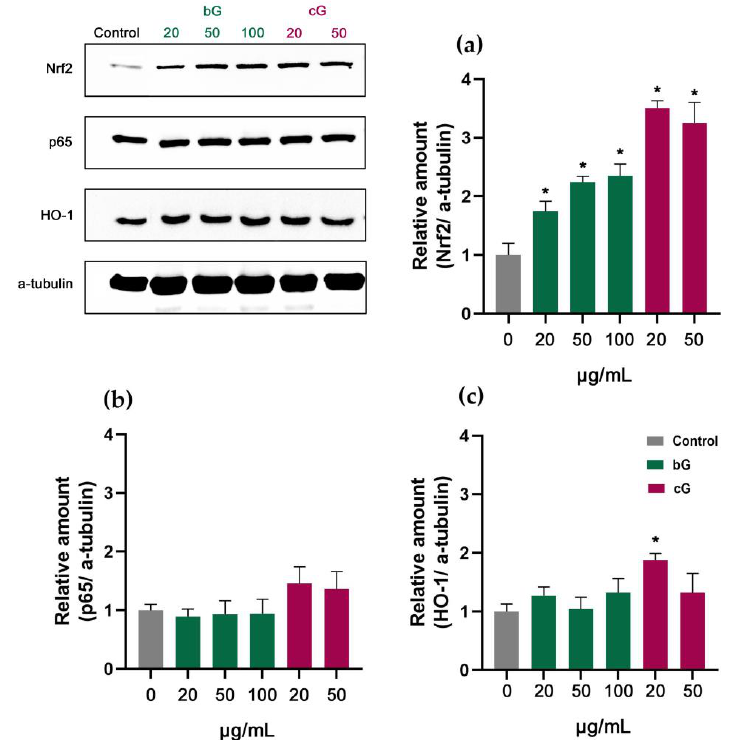
Figure 8. Relative amount of Nrf2 ( a ), p65 ( b ) and HO-1 ( c ) in NIH/3T3 cells. * Statistically significant difference from control ( p < 0.05).